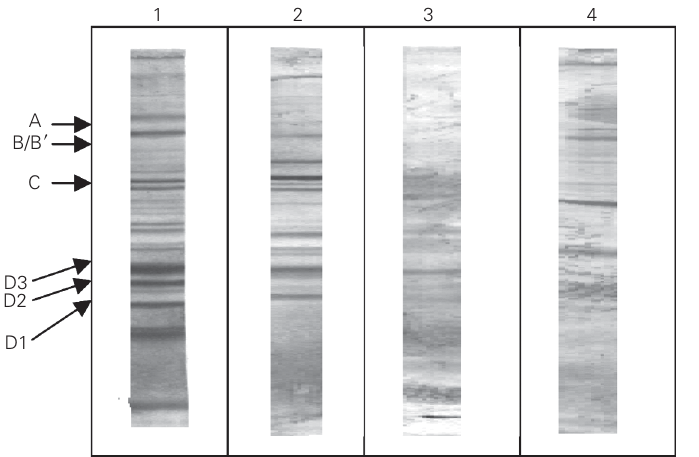
Figure 2. Western blot of serum from a patient with chagasic heart disease (lane 2 - high degree of reactivity in Figure 1, Panel I) and from a patient with non-chagasic heart disease (lane 3 - high degree of reactivity in Figure 1, Panel II) using HeLa UsnRNPs. Lane 1 , Serum from a patient with systemic lupus erythematosus as positive control; lane 4 , normal human serum. The typical human Sm proteins (A, B/B’, C, D1, D2, D3) are